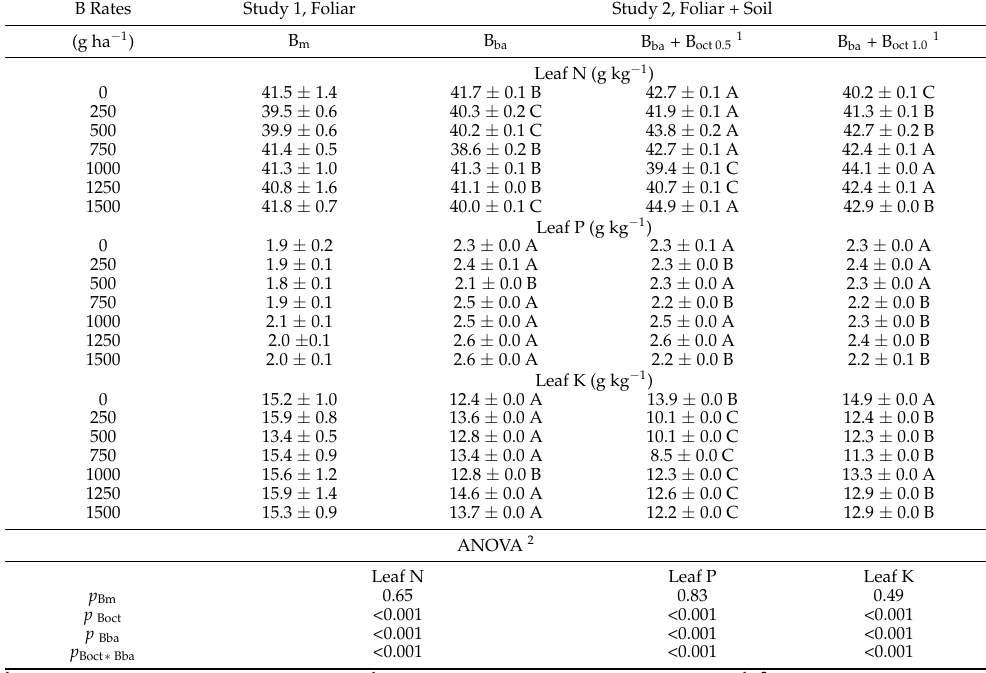
Table 4. Contents of leaf nitrogen, phosphorus, and potassium (g kg − 1 ) in Study 1 with foliar application of B (Bm, monoethanolamine) using six B rates (250, 500, 750, 1000, 1250 and 1500 g ha − 1 ), and in Study 2 with B application in soil using sodium octaborate (Boct) with two rates (Boct0.5: 0.5 kg ha − 1 ; and Boct1.0: 1.0 kg ha − 1 ), and the foliar B application using boric acid (Bba) with six rates (250, 500, 750, 1000, 1250, and 1500 g ha − 1 ).